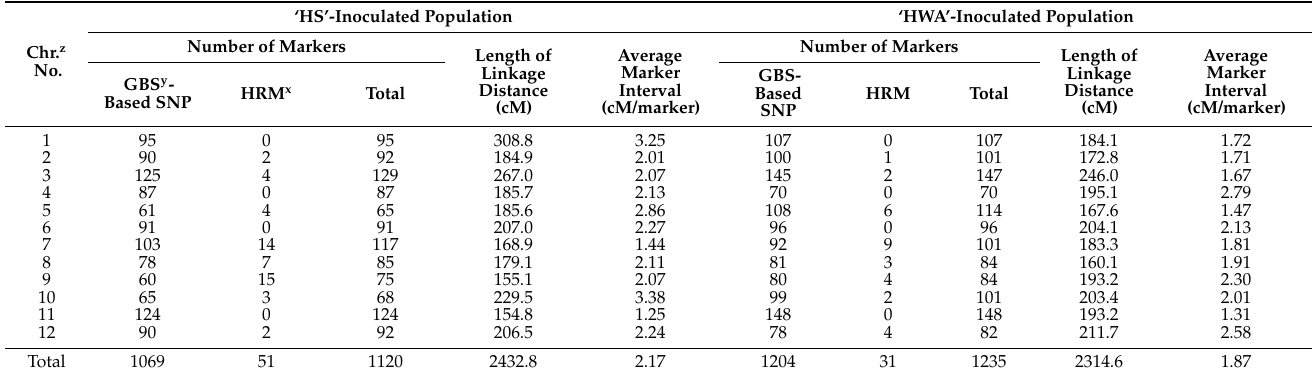
Table 3. Summary of two pepper genetic linkage maps generated by GBS